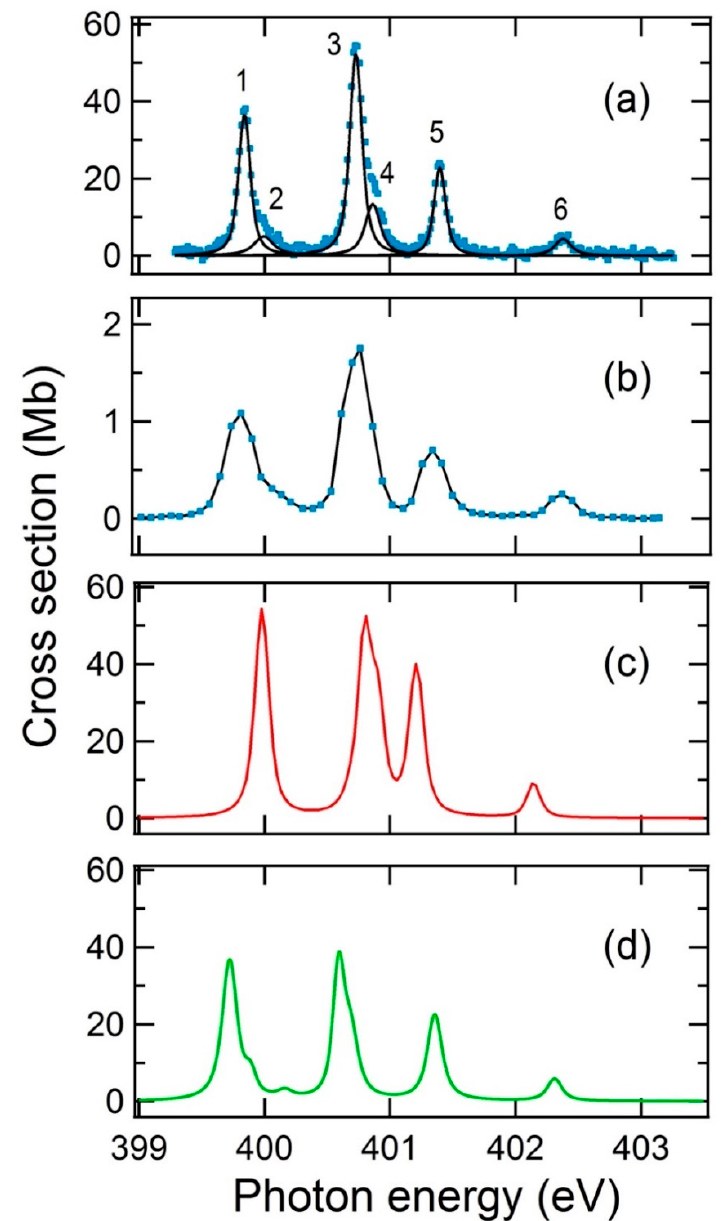
Figure 4. Photoionization cross-sections of the N + atomic ion in the photon energy region of the 1𝑠 ⟶ 2𝑝 excitations. ( a ) Measured in the single ionisation channel (65 meV energy band pass). ( b ) Measured in the double ionisation channel (225 meV band pass). ( c ) Multiconfiguration Dirac-Fock (MCDF) simulation of the total photoabsorption cross-sections. The theoretical energy values are shifted by +0.7 eV in the figure. ( d ) R-matrix with pseudo-states theoretical (RMPS) simulation of the total photoionization cross-sections.